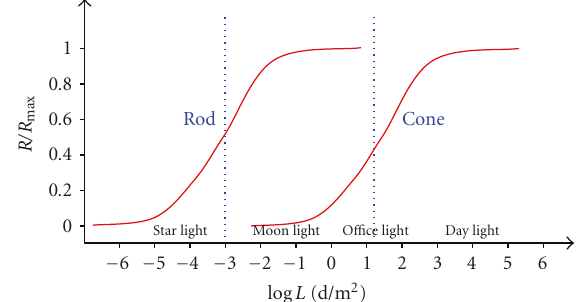
Figure 1: Human visual system mapping curve.